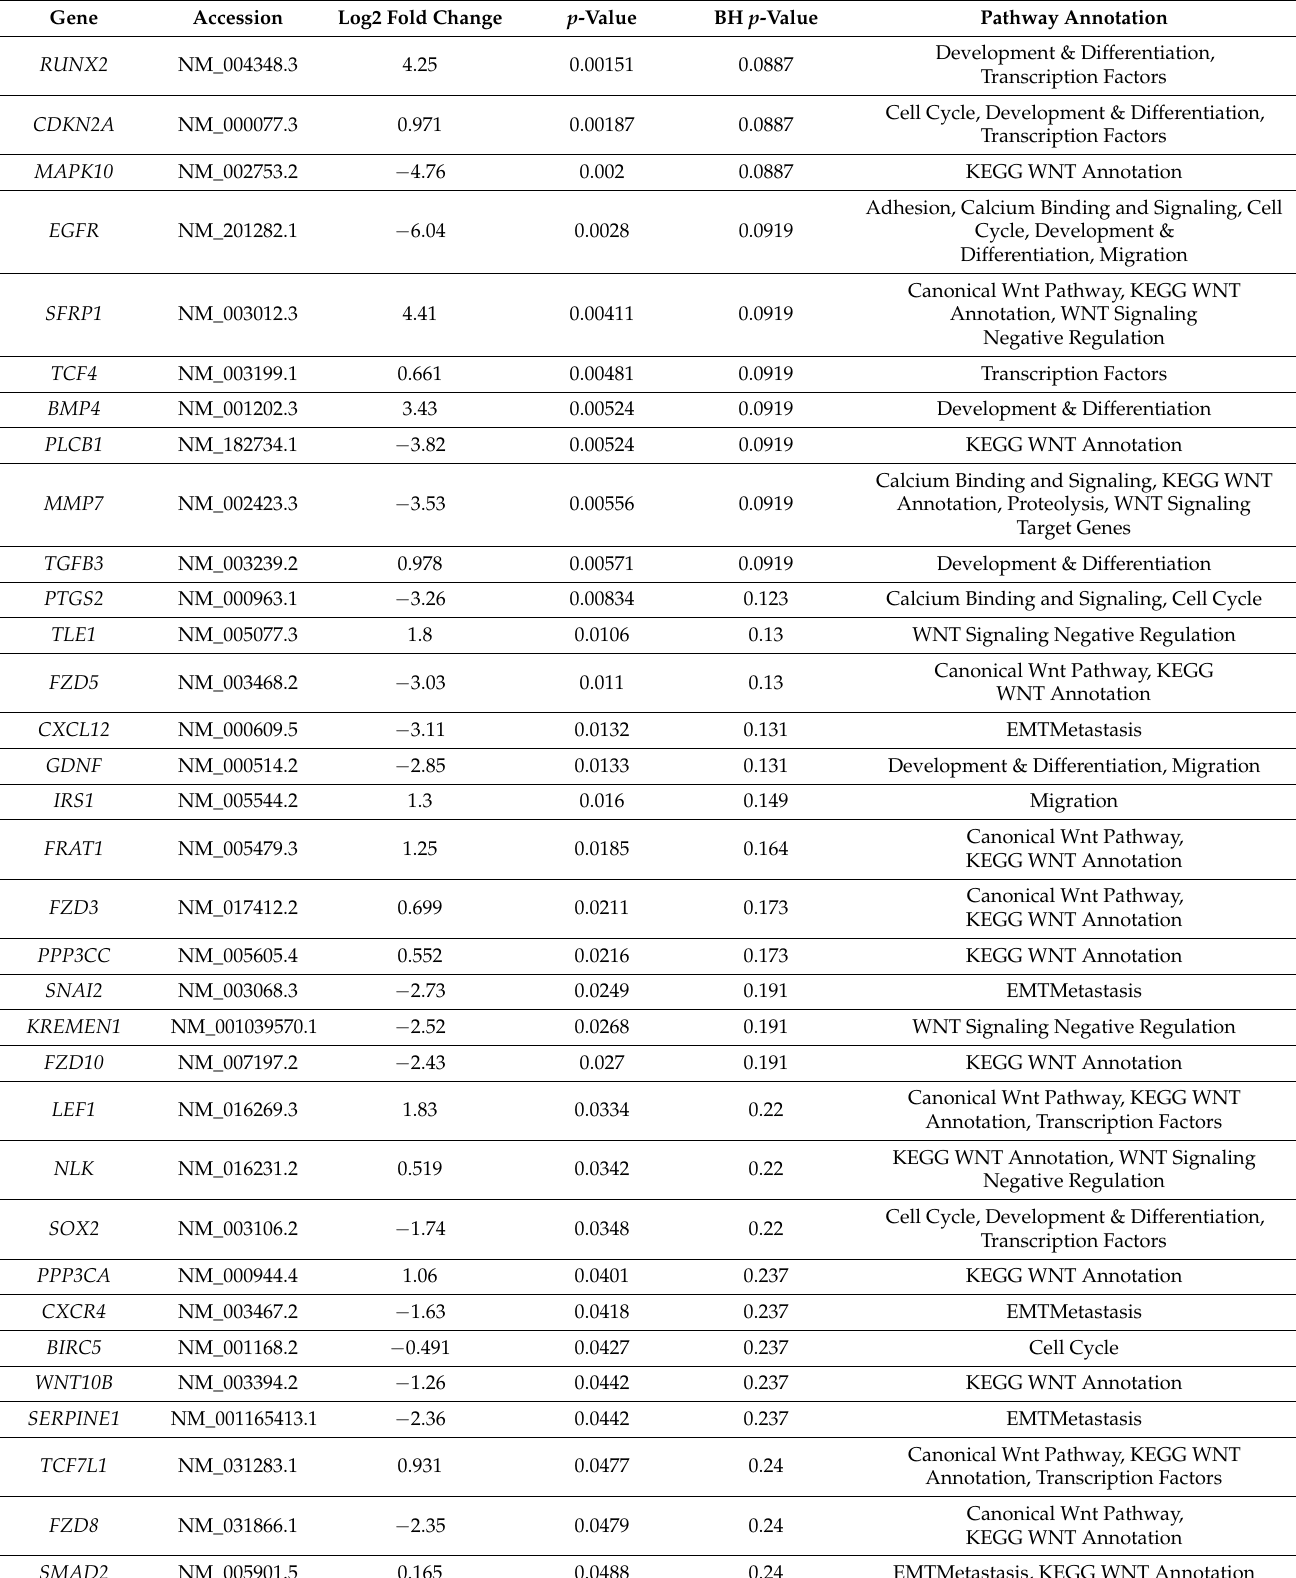
Table 3. Expression profile of the genes of the WNT pathway evaluated by nCounter Nanostring